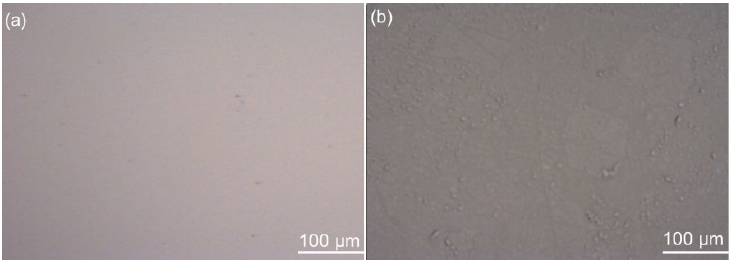
Figure 1. Images (500 µ m × 400 µ m) of the surface of ( a ) Si substrate and ( b ) Ti substrate obtained by Figure 1. Images ( 500 μm × 400 μm) of the surface of ( a ) Si substrate and ( b ) Ti substrate obtained digital optical by digital optical microscopy.